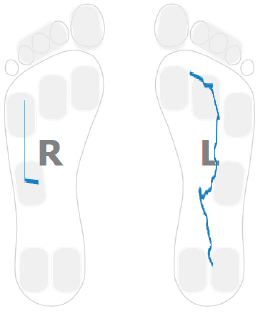
Figure 8. Post-stroke survivor pressure patterns.